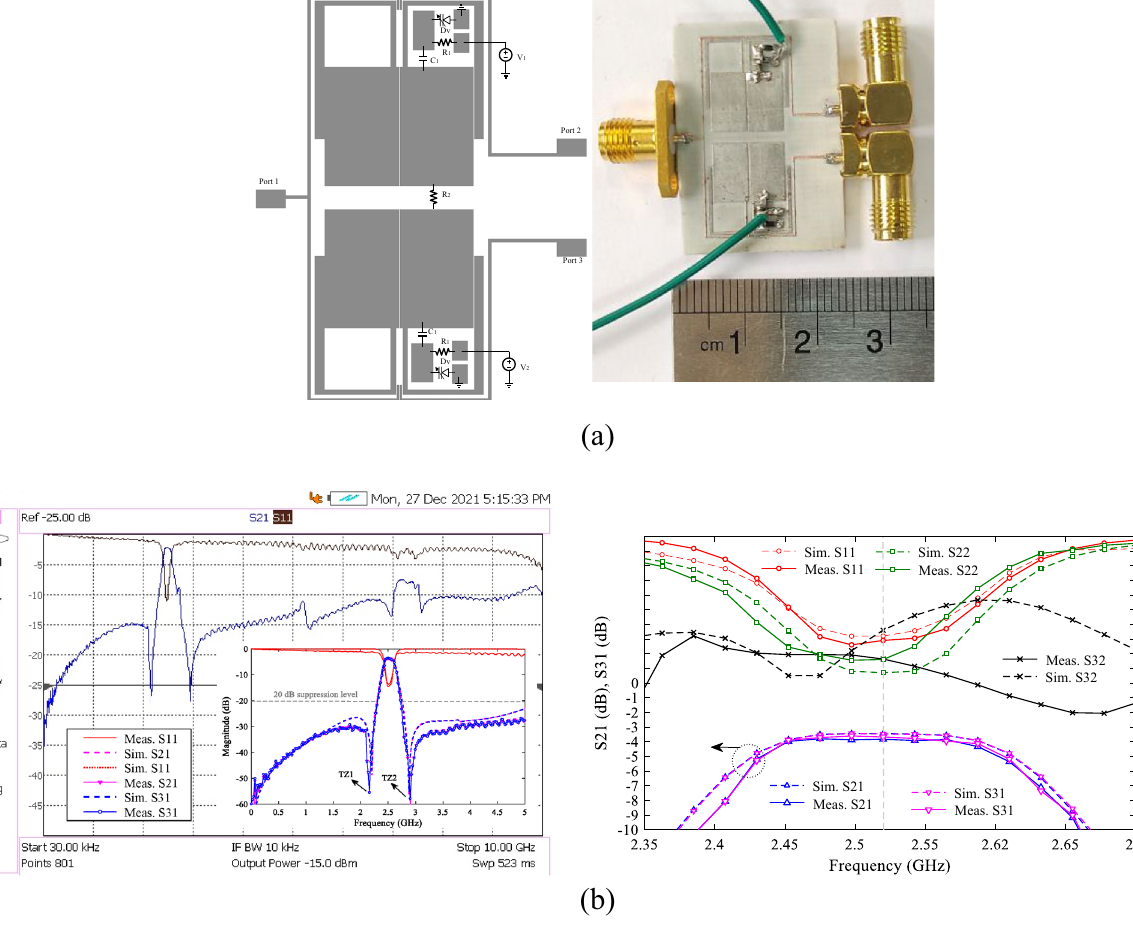
Figure 11. Proposed WPD with tunable power-dividing ratio (second design), ( a ) layout and photograph of fabrication structure, ( b ) simulation and measurement results at V1 and V2 = 4 V.